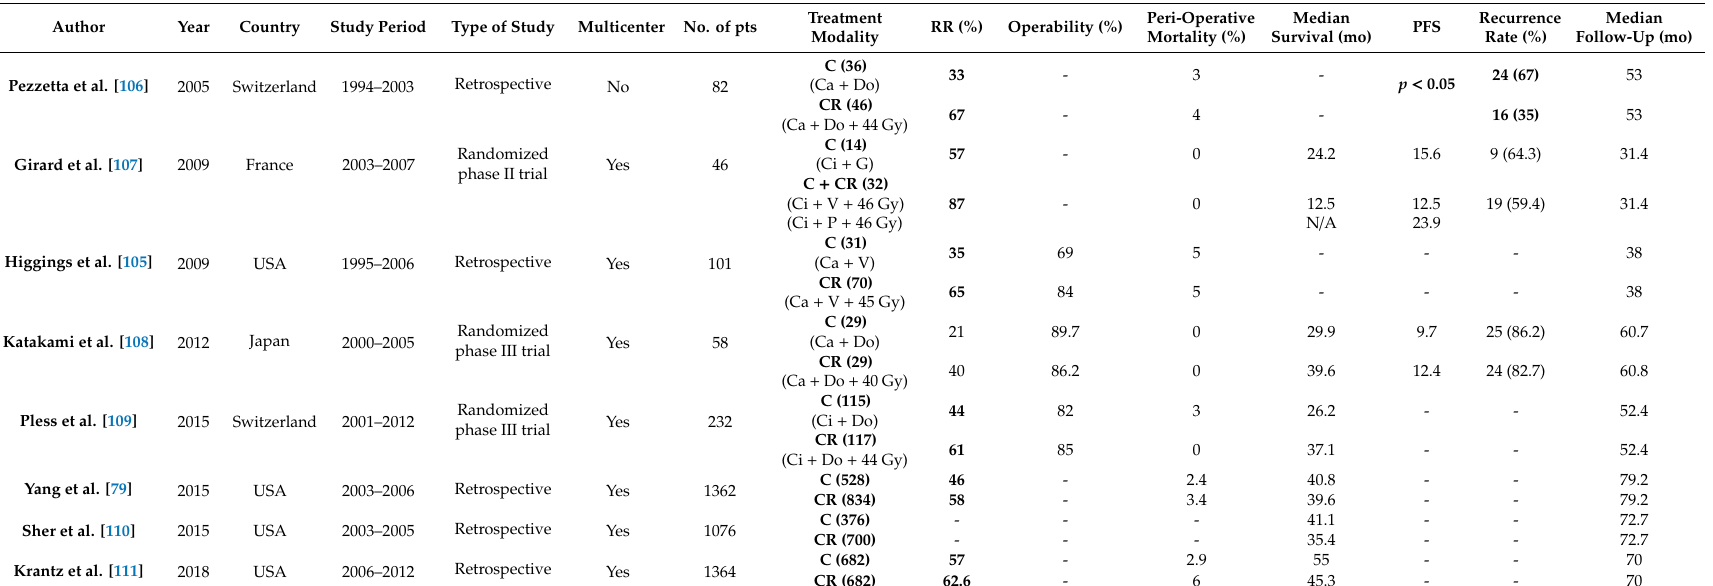
Table 2. Studies reporting the outcomes of completely resected IIIA-pN2 patients treated with neoadjuvant chemotherapy or chemoradiotherapy over the last 20 years. Di ff erence of values in bold is statistically